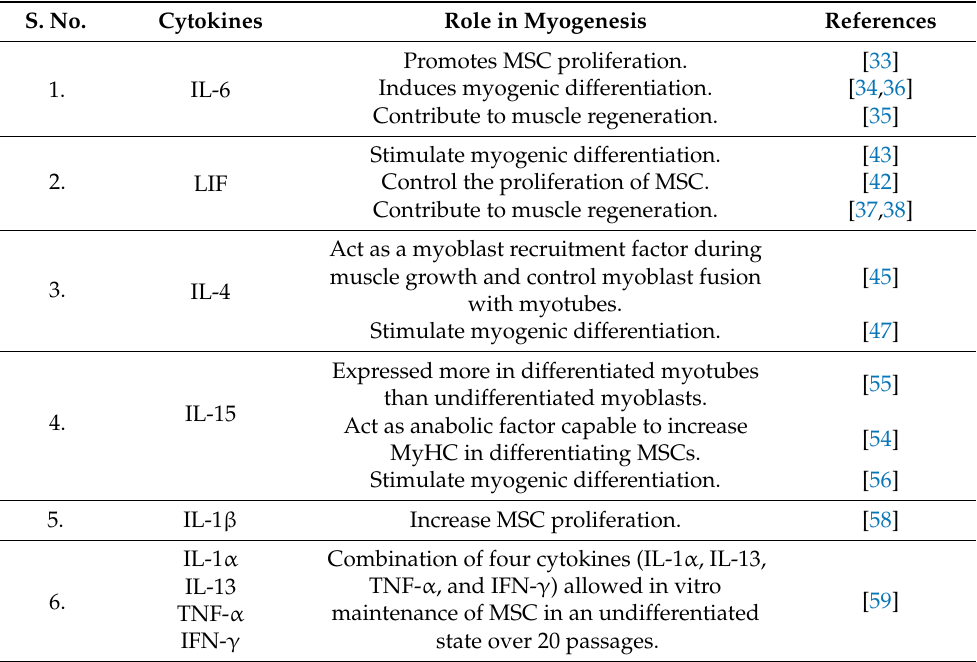
Table 1. Role of cytokines in